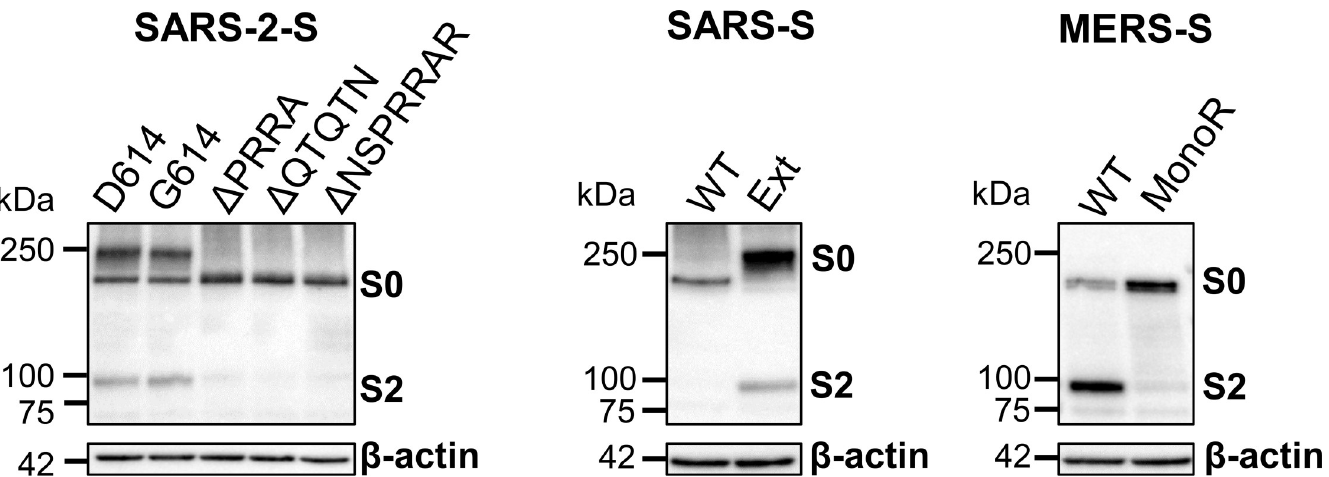
Fig 4. S1/S2 cleavage efficiency of WT and mutant spikes, expressed in HEK293T cells. The SARS-2-S, SARS-S and MERS-S proteins were expressed in HEK293T cells and at 48 h post transfection, extracts were made for western blot analysis of the V5-tagged proteins in uncleaved (S0) or S1/S2 cleaved form. β -Actin served as loading